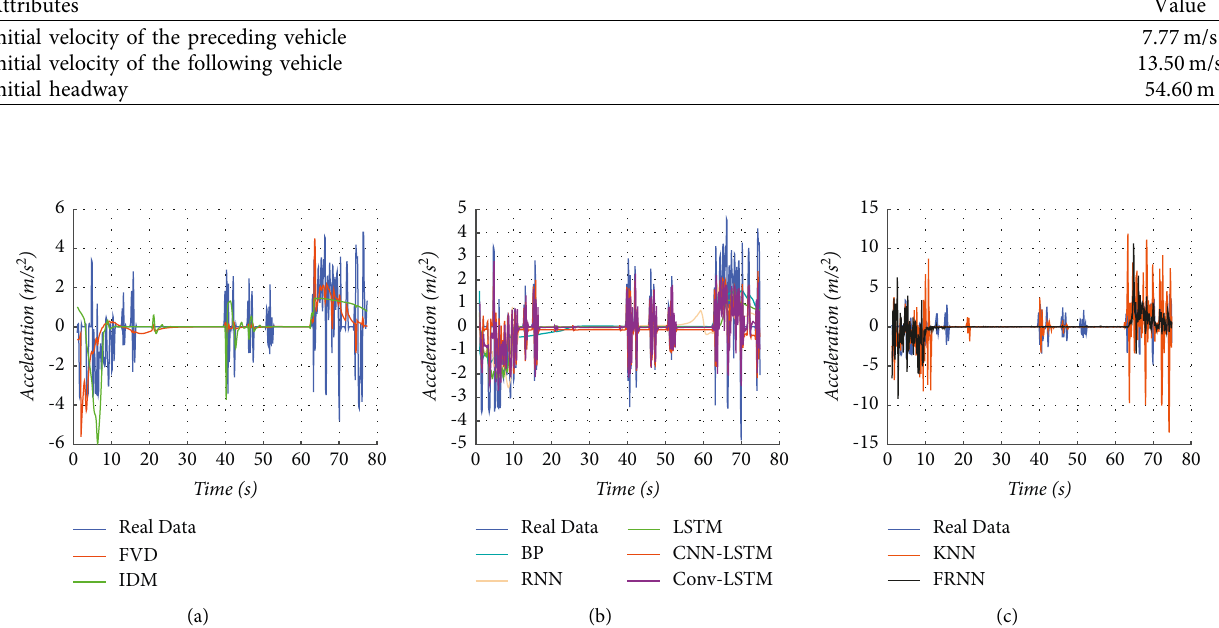
Figure 16: Acceleration comparison of discontinuous traffic flow. (a) Conventional models; (b) ANN CF- (A); and (c) ML